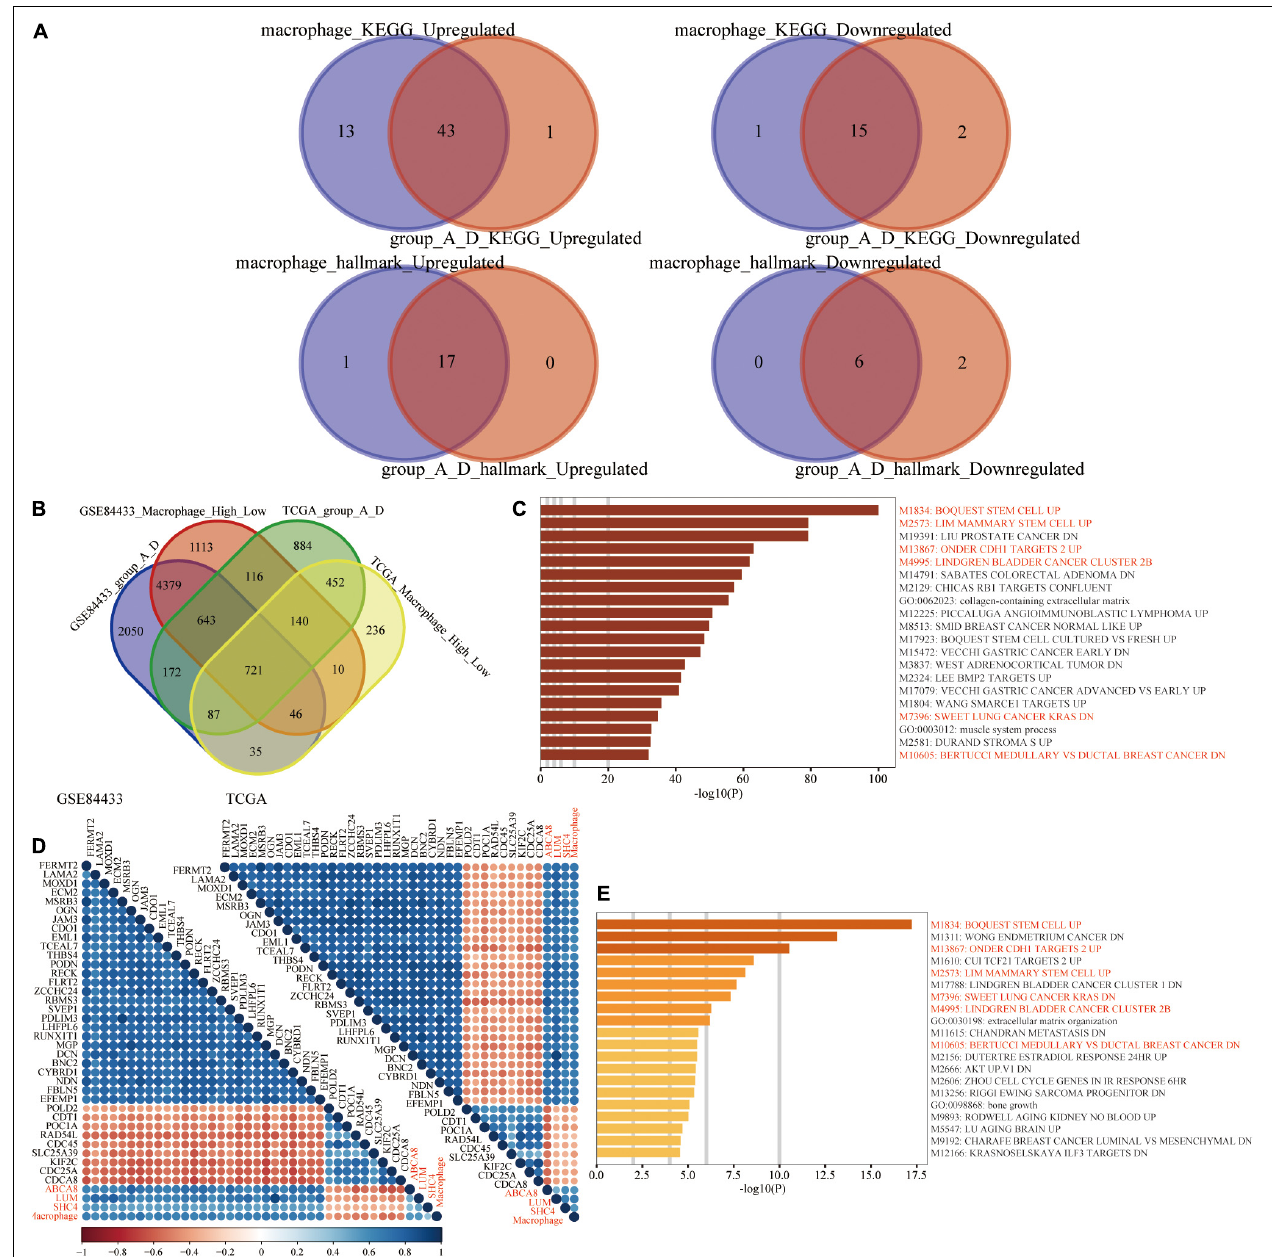
FIGURE 11 | Enrichment analysis. (A) GSEA results of macrophage grouping and 3-gene signature grouping were mostly overlapped. (B) 721 differentially expressed genes (DEGs), shared by the high and low macrophage group and the 3-gene signature group A and D. (C) Based on the Metascape website, M1834: BOQUEST STEM CELL UP was the top functional enrichment result of 721 DEGs. (D) In the transcriptome data of the TCGA and GSE84433, 36 genes were highly correlated with 4 biomarkers (ABCA8, LUM, SHC4, and macrophage abundance). (E) M1834: BOQUEST STEM CELL UP was still the top functional enrichment result of 36 genes. Among the Top 20 enrichment results, 721 DEGs and 36 highly correlated genes had 6 identical enrichment results, which were highlighted in